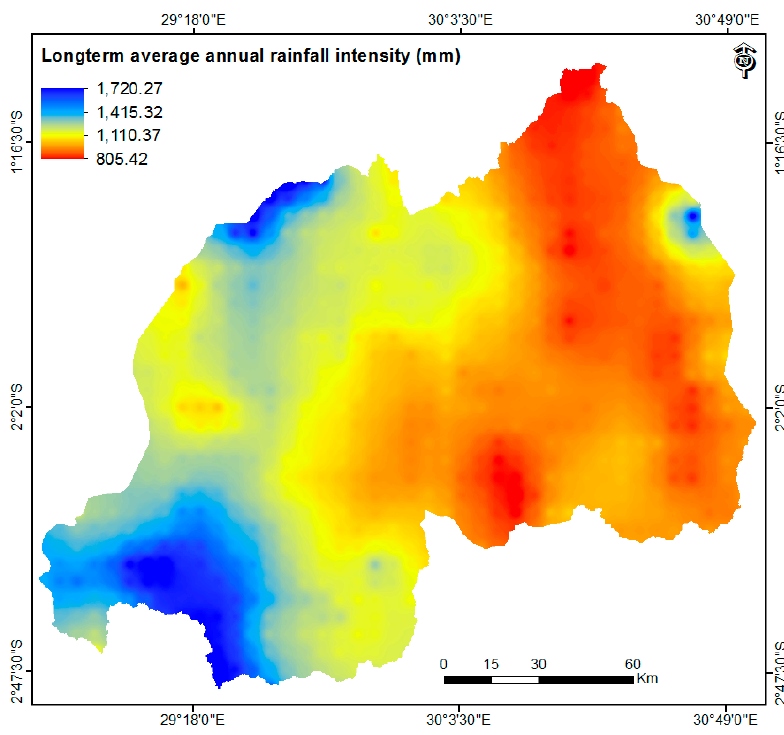
Figure 4. Long ‐ term average annual rainfall intensity in Rwanda (1990–2016). Figure 4. Long-term average annual rainfall intensity in Rwanda